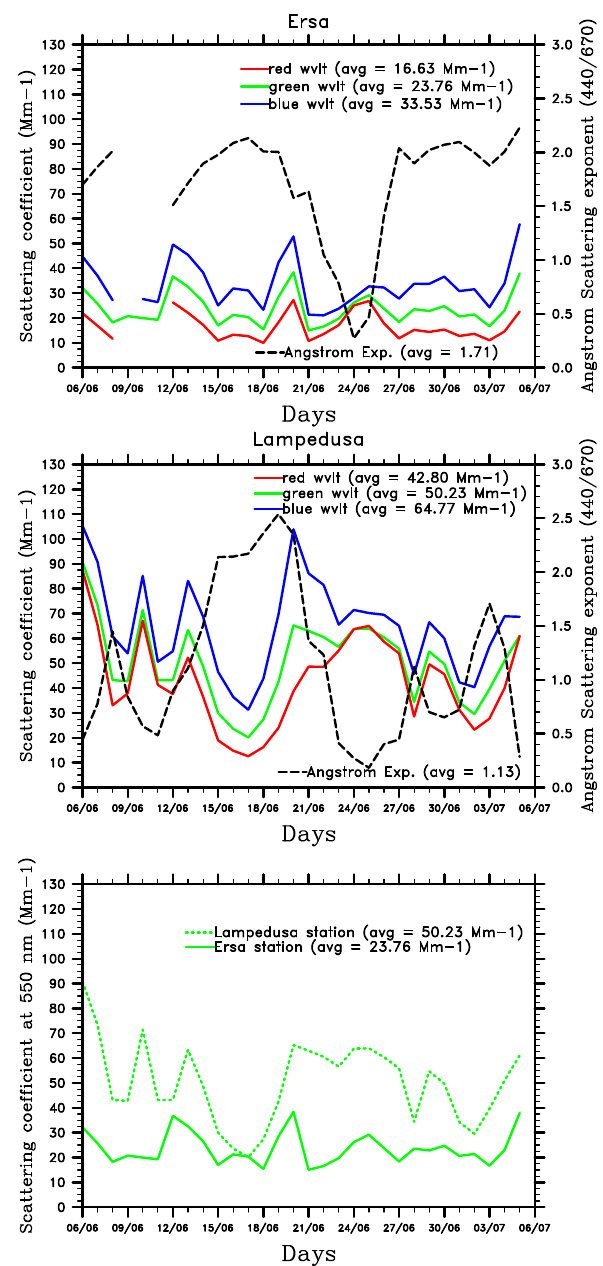
Figure 18. Time series of the daily scattering coefficient (in Mm − 1 ) estimated at the Ersa and Lampedusa stations. The daily Angström exponent (AE), calculated between 440 and 670nm, is also re-